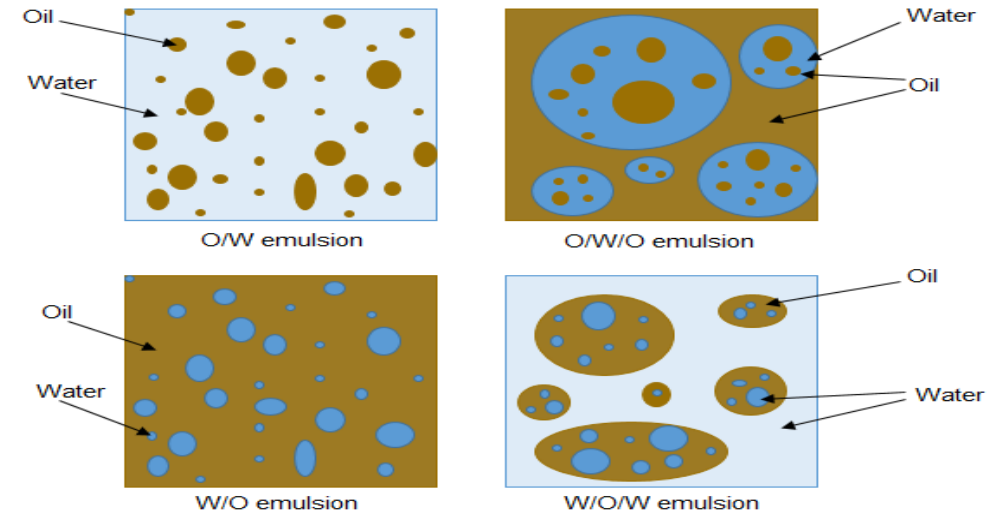
ff erent types of emulsions Figure 1. Different types of emulsions [25]. Figure 1. Di